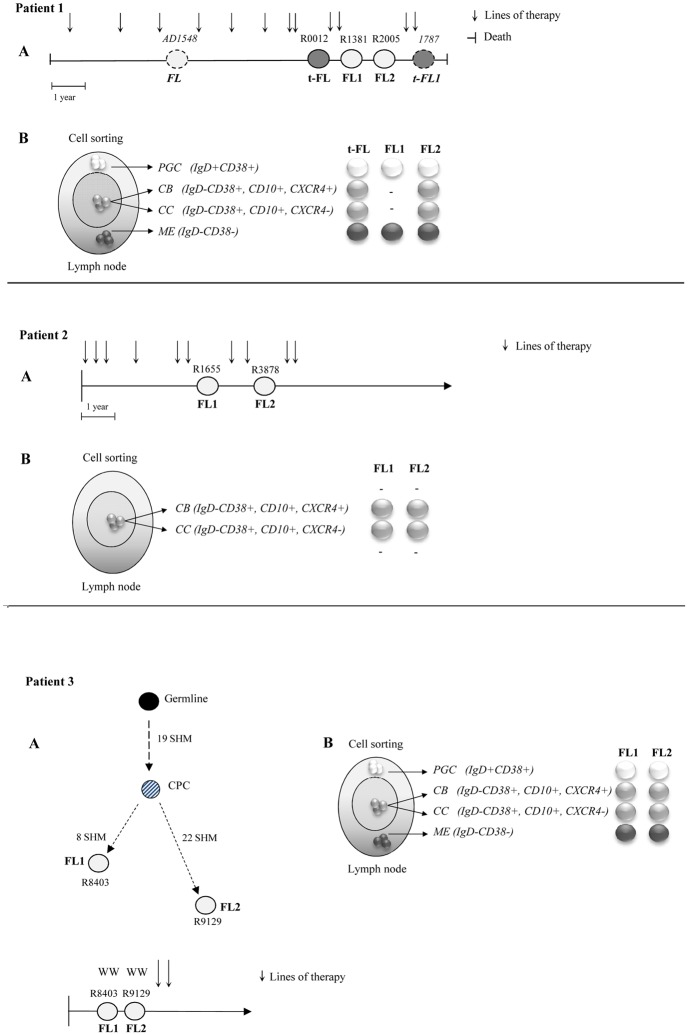
Characteristics of the patients and samples included in the study.(A) Three patients were included in the analysis: pt1 and pt2 displaying a pattern of direct evolution and pt3 of evolution through a CPC based on HH analysis. Biopsies were collected at different time points: at relapse/transformation (pt1 and pt2) and after a watch wait period (pt3). In pt 1 two additional biopsies (AD1548 and 1787) analyzed only on the SNP array are shown. In pt1 all samples had an identical MC whilst in pt2 the MC sequences from samples R1655 FL1 and R3878 FL2 showed 2 different dominant clones carrying 3 discriminating mutations (S7 Fig). Because these 3 bases also differ from the germline sequence a pattern of direct evolution could not be excluded. (B) Twenty-two samples, from 4 flow-sorted sub-populations, included in the deep sequencing study: pre-germinal center (PGC) (IgD+CD38+) white circles, the germinal center centroblasts (CB) (IgD+CD38+CD10+CXCR4+) and centrocytes, (CC) (IgD+CD38+CD10+CXCR4-) light grey circles and memory enriched (ME) (IgD-CD38-) dark grey circles. The 2 CC CD77- sorted sub-population from R0012 t-FL and R1381 FL1 biopsies, which were part of the deep sequencing study but not included in the final analysis are not shown. The FL sequences are depicted as white circles, the t-FL clones as grey circles, the germline sequence as black circles and the putative CPC sequence as a dashed grey circle. The 2 samples not included in the deep sequencing of IgH-VH gene are depicted as dotted circles. Each vertical arrow represents a line of therapy; the left hand vertical bar shows the time of diagnosis and the right hand vertical bar the time of death. FL = Follicular Lymphoma; t-FL = transformed Follicular Lymphoma; WW = watch and wait.